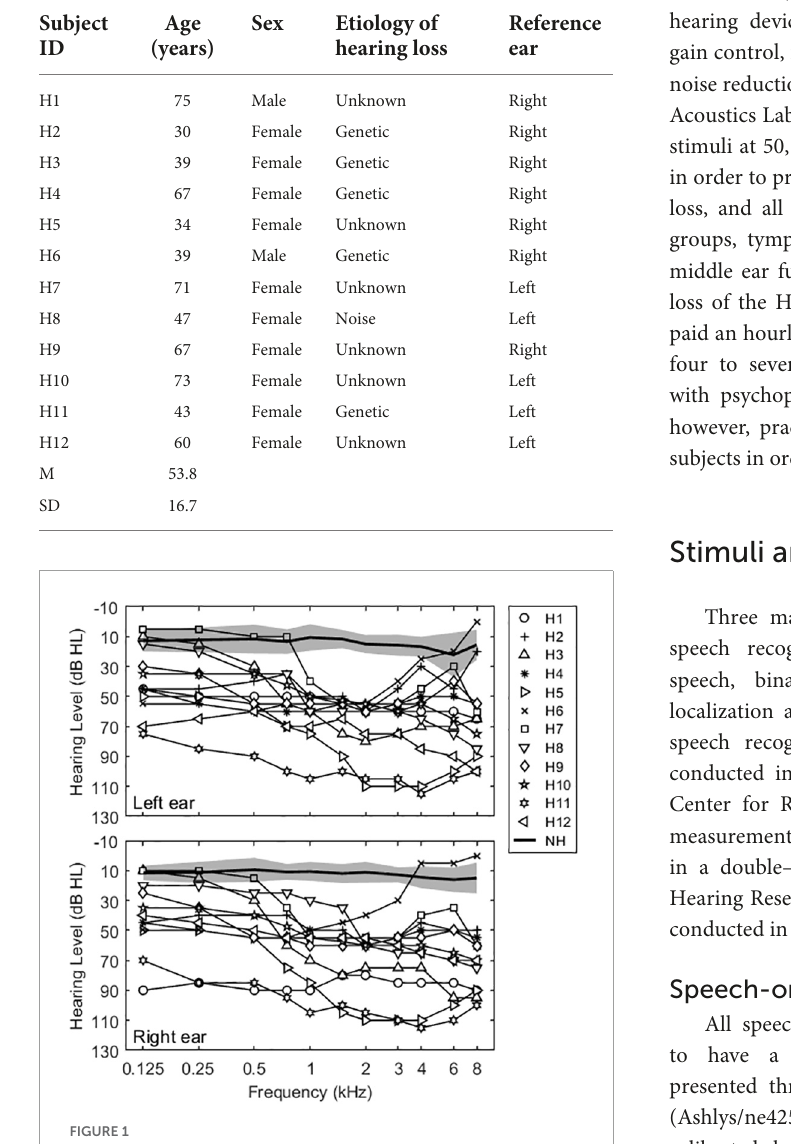
HL for left and right ears, respectively. Figure 1 shows group- averaged audiograms for NH subjects (thick solid lines) and individual audiograms for bilateral HA subjects (lines with open symbols) for left and right